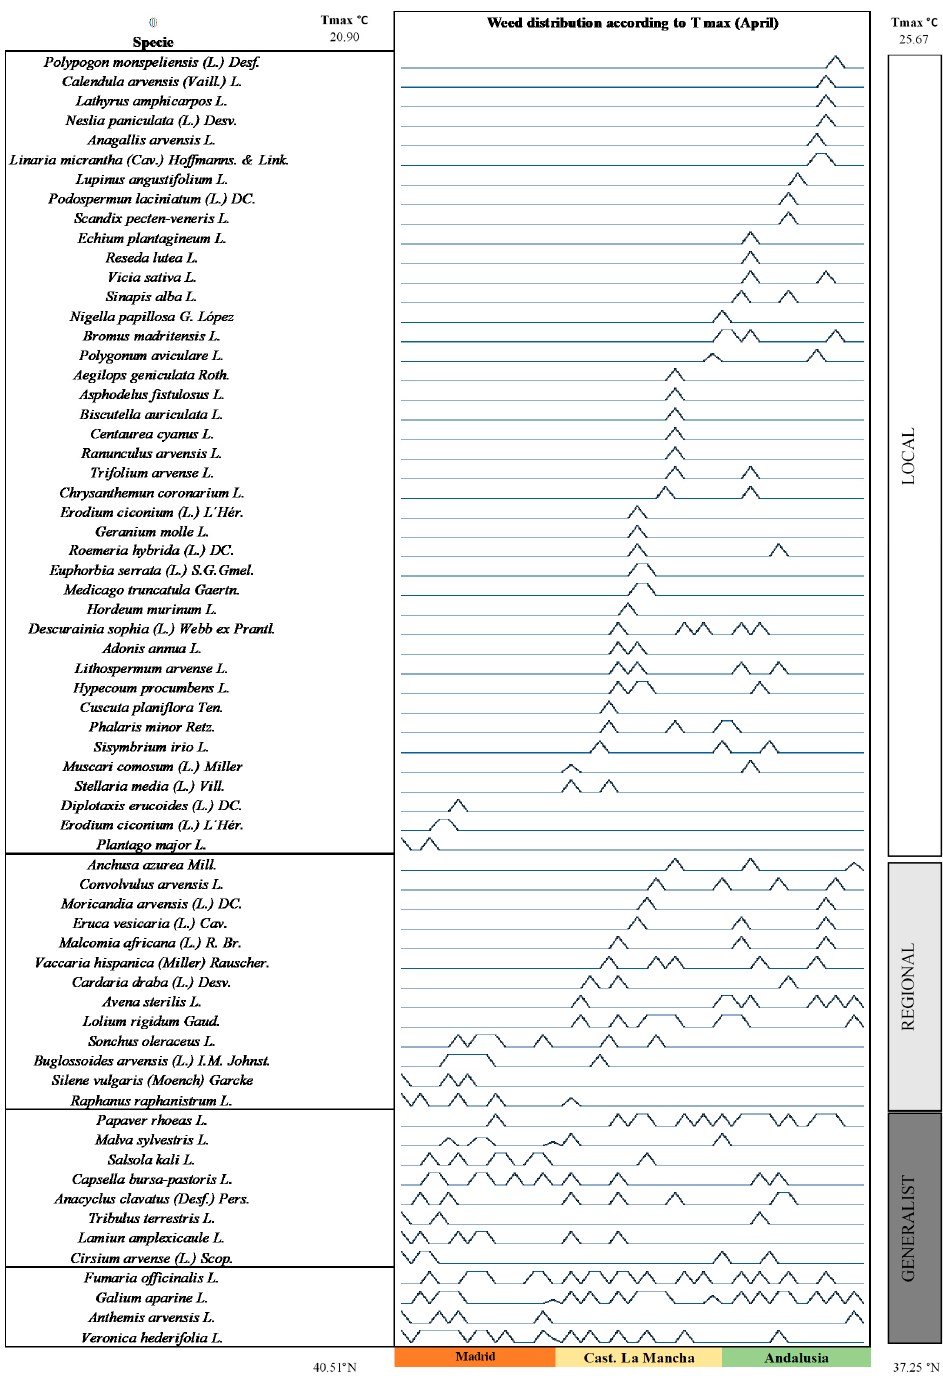
Figure 2. Graphical pattern of arable weeds distribution according to the Tmax in April.